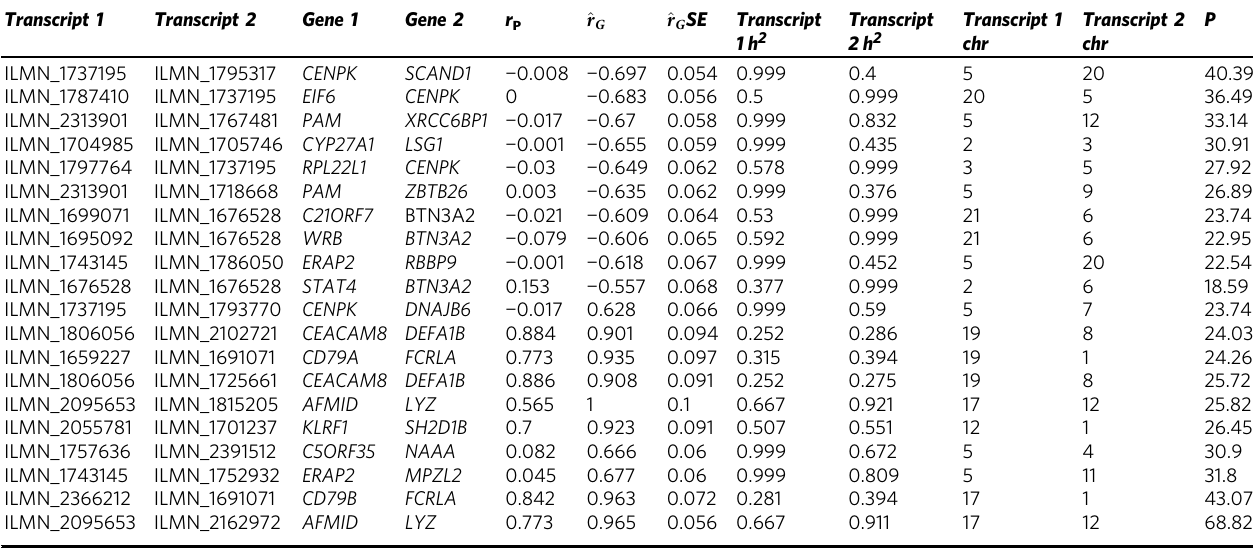
Table 1 Summary of GCTA results for 20 signi fi cant interchromosomal ^ r G